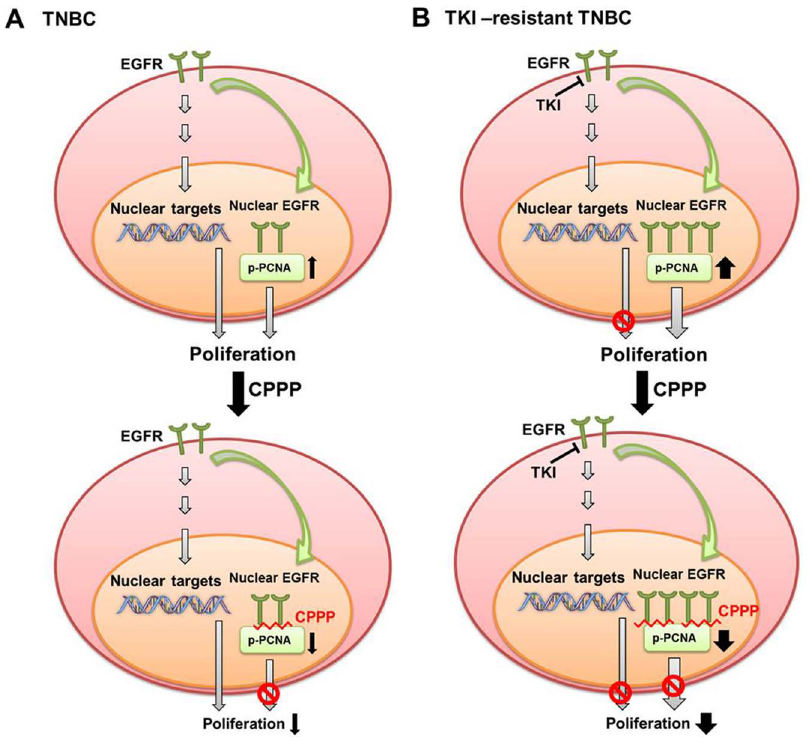
Figure 6. A proposed model of CPPP in TNBC treatment. The schematic illustrates the potential mechanism of CPPP in treatment of TKI- sensitive and -resistant TNBC. (A) In TNBC, both the classical EGFR membrane signaling and nuclear EGFR-mediated phosphorylation of PCNA at Y211 exist for cell proliferation. CPPP disrupts the nuclear EGFR-mediated PCNA phosphorylation at Y211, leading to suppression of proliferation. (B) In EGFR TKI-resistant TNBC, EGFR TKIs abrogate the classical EGFR membrane signaling, and thus elevate nuclear translocation of EGFR to phosphorylate more PCNA at Y211, triggering more second compartment of proliferation. CPPP attenuates more nuclear EGFR-mediated cell proliferation through repression of Y211 phosphorylation in the presence of EGFR